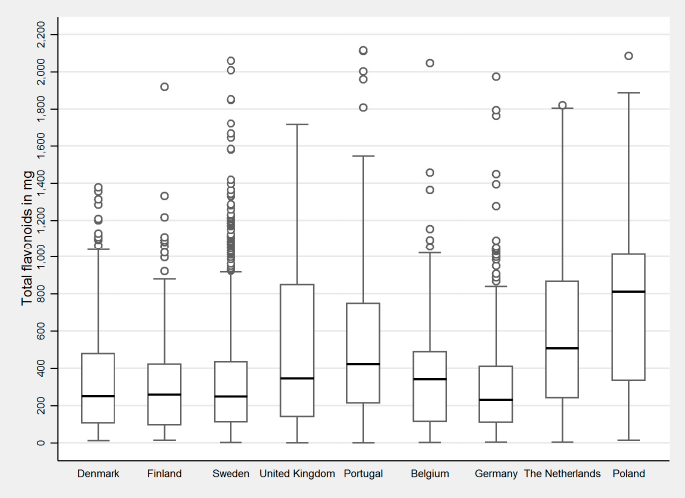
Figure 1. Total flavonoid intake in the adults participating in the GA 2 LEN Follow-Up Survey who had valid lung function data ( n = 2599).